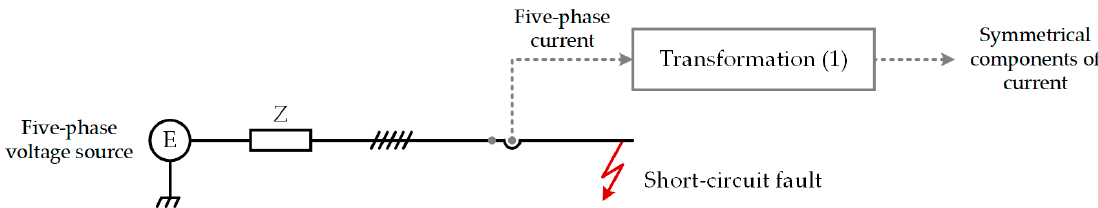
Figure 4. MATLAB Simulink model of five-phase electrical system.